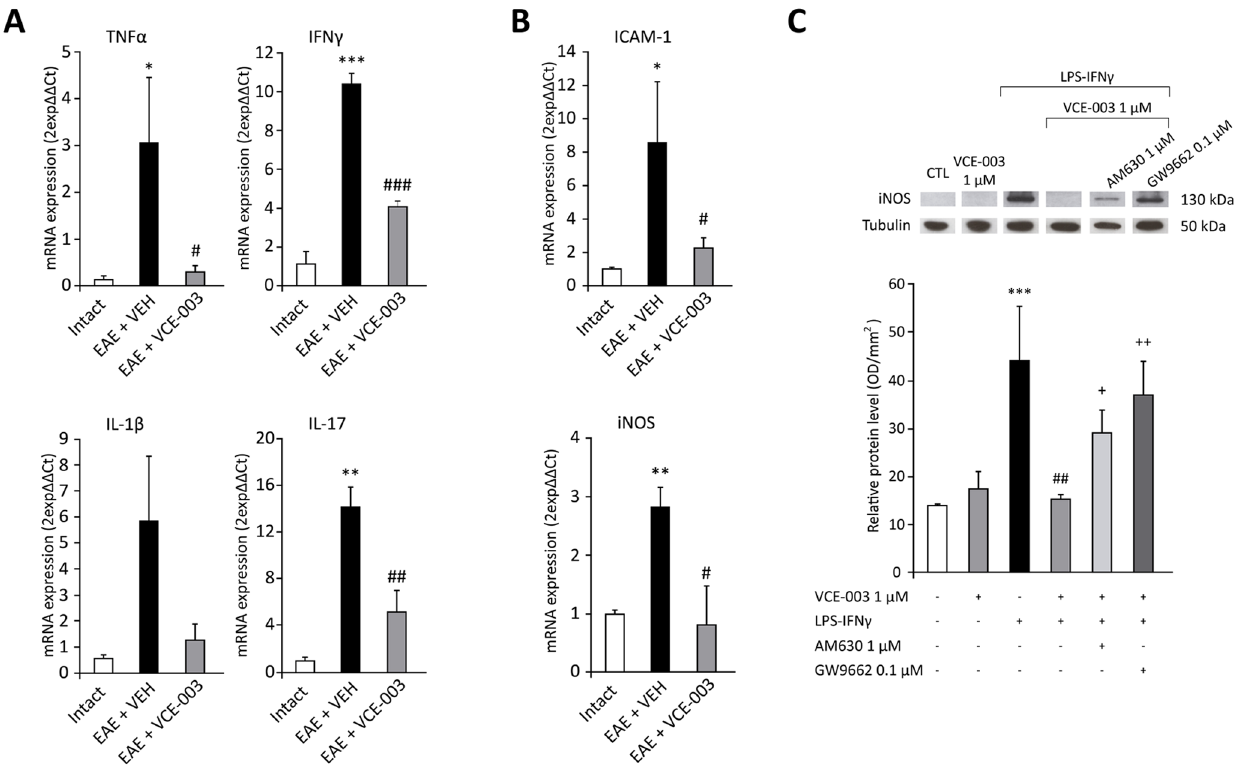
Figure 7. VCE-003 reduces the expression of inflammatory marker mRNAs in the spinal cord and of iNOS protein in BV2 cells. VCE- 003 decreased the mRNA expression of TNF a , IFN c , IL-1 b and IL-17 (A), and the adhesion molecule ICAM-1 and iNOS (B). (C) Immunoblotting of iNOS. Proteins in lysates (30 m g) from BV2 cells stimulated with LPS (50 ng/ml) and IFN c (100 u/ml), and pre-treated with VCE-003 (1 m M). Both CB2 and PPAR c antagonists (AM630 1 m M and GW9662 0.1 m M, respectively) were administered 10 min before than VCE-003 treatment. The results are presented as the relative ratio of proteins, where the iNOS signal obtained by densitometric analysis was normalized to the tubulin signal. VCE-003 treatment significantly reverses the LPS-IFN c -induced effects to the control situation, and both CB2 and PPAR c antagonists blocked this effect of VCE- 003. The results in (A, B) are shown as the means 6 SEM: *p=0,011 vs Intact (TNF a ); *p=0,003 vs Intact (ICAM-1); **p , 0.01 vs Intact; # p=0.05 vs EAE + VEH (ICAM-1); ## p , 0.01 vs EAE + VEH; ### p , 0.001 vs EAE + VEH). The results in (C) are shown as the means 6 SEM from three independent experiments performed in triplicate: ***p , 0.001 vs CTL; ## p , 0.01 vs CTL + LPS- IFN c ; + p=0.034 vs VCE-003 1 m M + LPS- IFN c ; ++ p=0.002 vs VCE- 003 1 m M + LPS- IFN c .